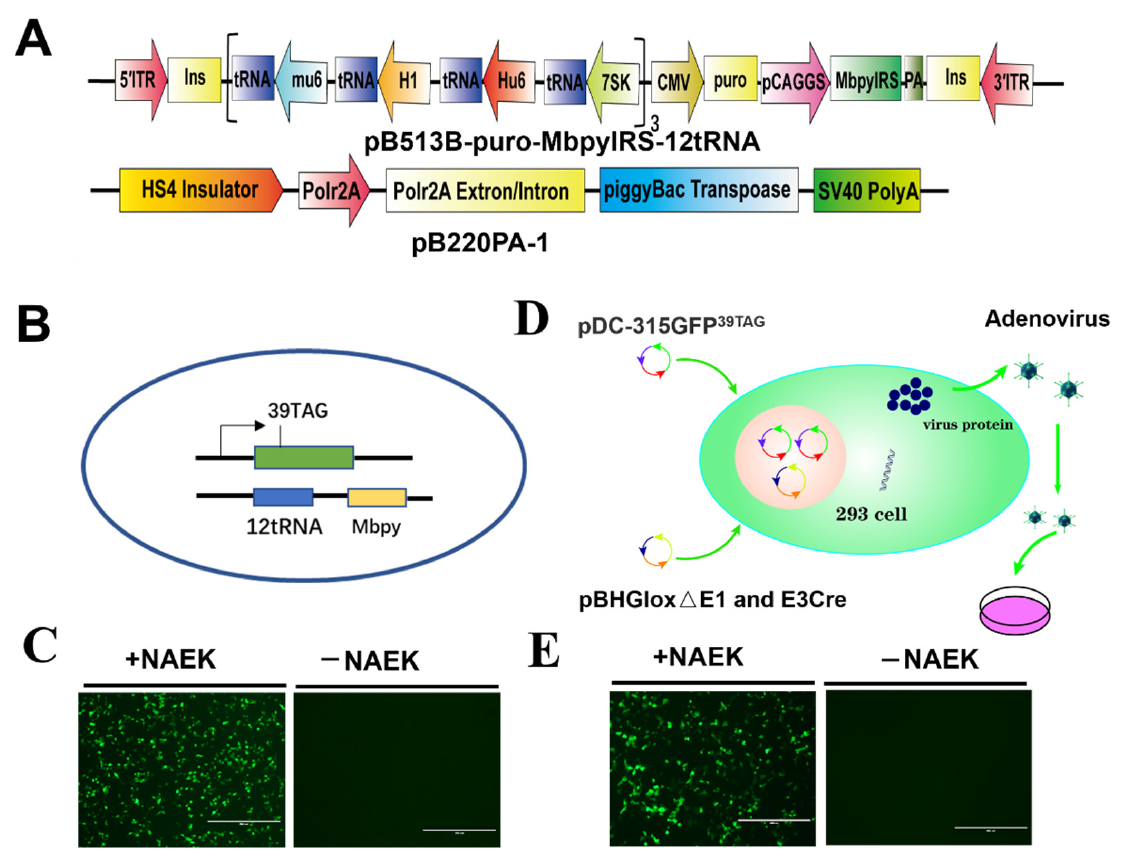
Figure 4. Generation of MbpylRS/tRNA Pyl pair delivery vector and reporter adenovirus. ( A ) A Pig- gyBac transposon vector, pB513B-puro-MbpylRS-12tRNA, and a helper vector containing the PB transposase expression cassette, PB220A-1, were used to generate orthogonal transgenic stable cell lines. ( B ) GFP with an amber codon at position 39 was used as a reporter gene. ( C ) Functional GFP was visualized by fluorescence microscopy in the presence of the MbpylRS/tRNA Pyl pair and UAA. Scale bars, 400 µm. ( D ) Schematic diagram of generating a recombinant adenovirus harboring GFP 39TAG reporter gene. ( E ) Recombinant adenovirus was confirmed in RK13 cells; RK13 cells were first transfected with pB513B-puro-MbpylRS-12tRNA plasmid, then infected with recombinant ad- enovirus. The function of adenovirus was verified according to the expression of GFP 39TAG . Scale bars, 400 µm.